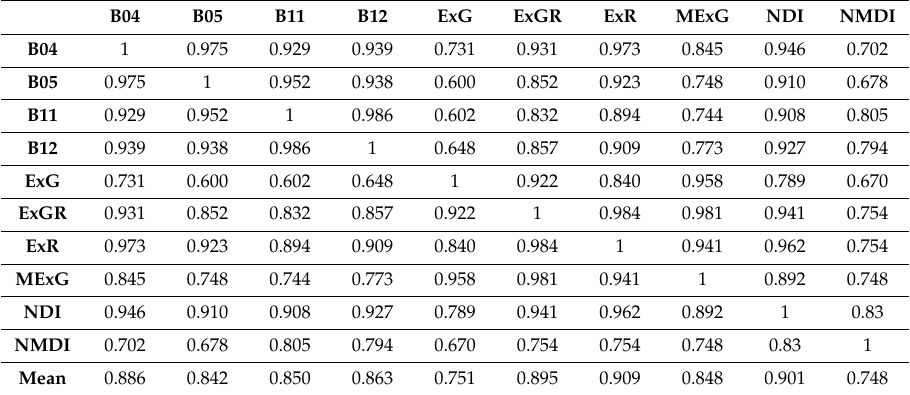
Table 4. Pearson correlation between